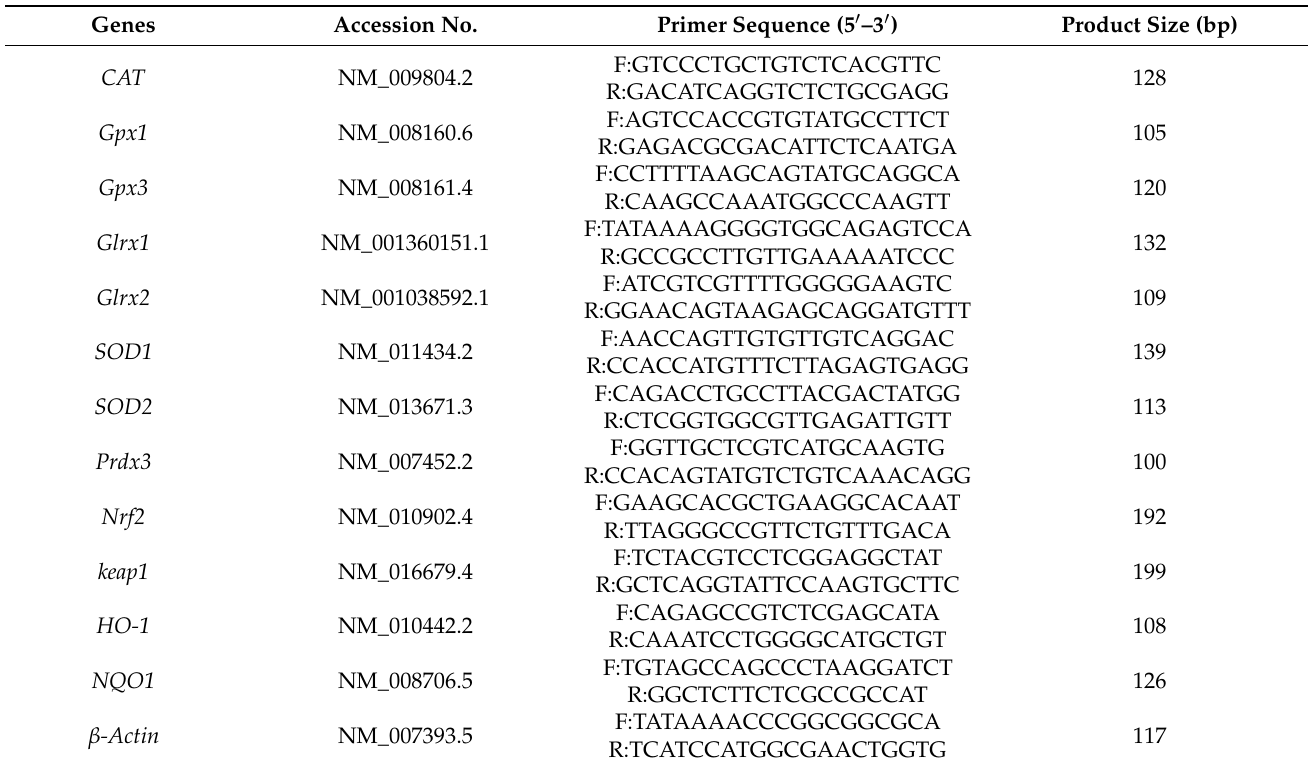
Table 2. Primers for